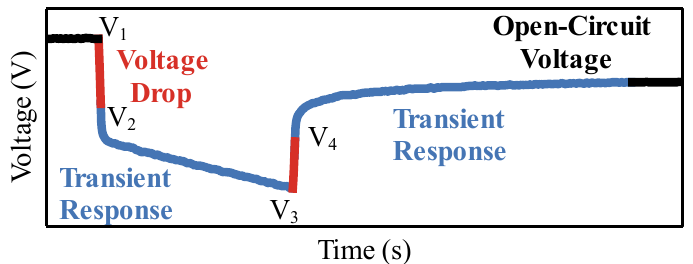
Figure 2. Explanation of a single pulse of the pulse discharge characterization